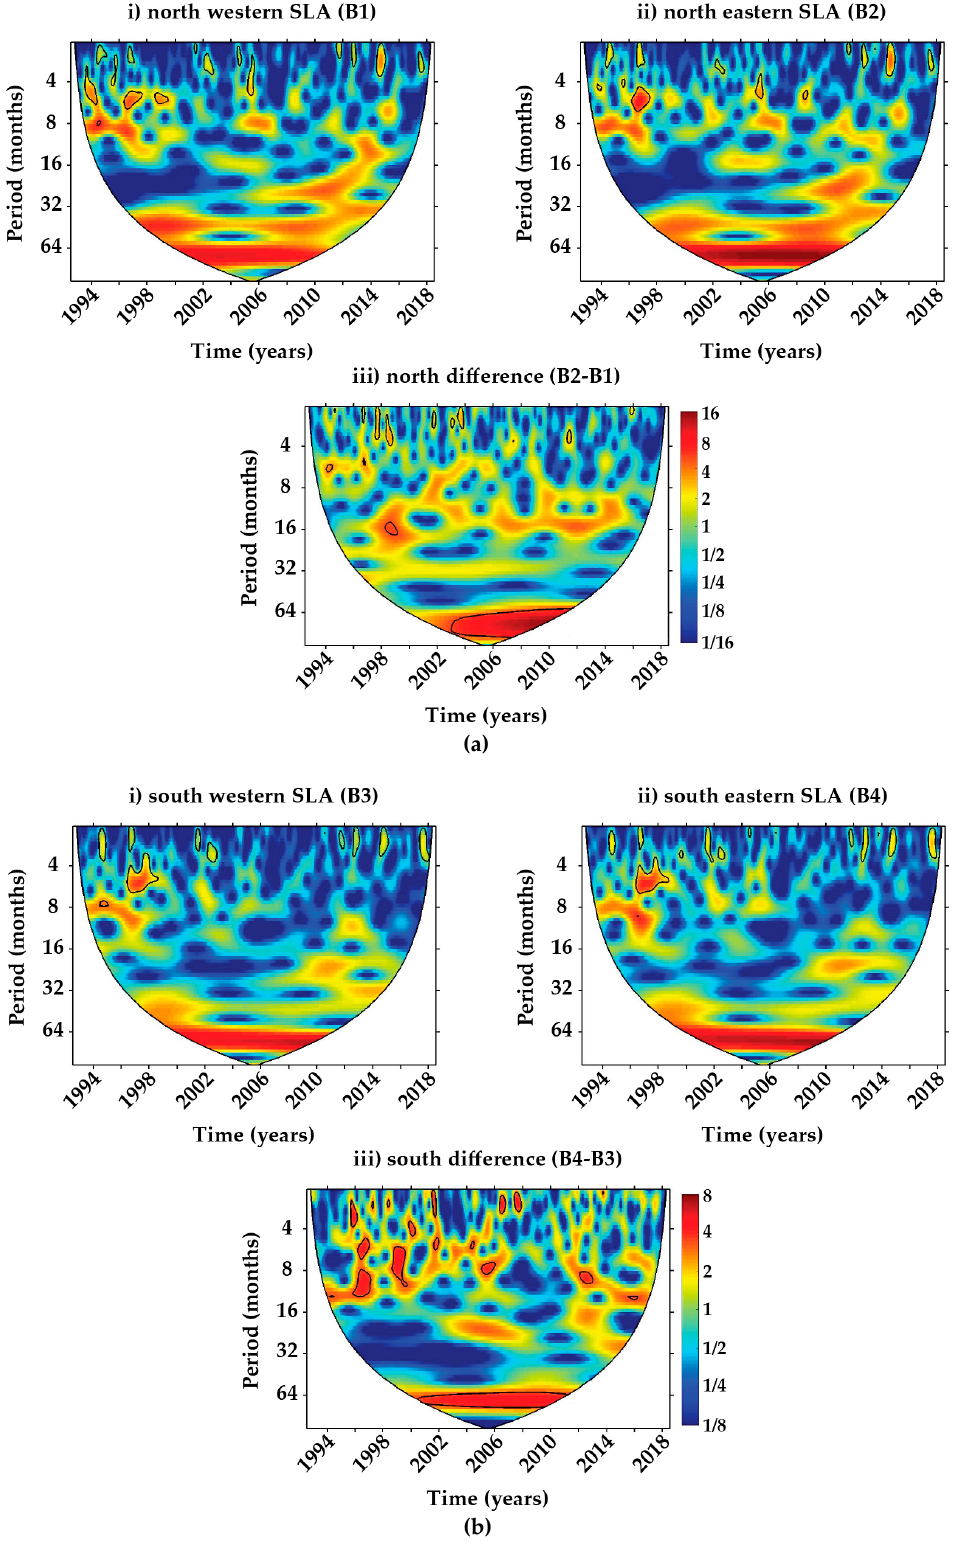
Figure 7. The wavelet plots after removing the annual signals for the western basin, eastern basin, and their difference ( a ) for the northern Red Sea and ( b ) for the southern Red Sea. In brief, a significant seasonally reversing EW difference pattern exists in the Red Sea. The average annual cycle of EW difference for the northern, southern, and whole basin of the Red Sea is shown in Figure 8. On average, the eastern side is higher than the western side from November to March and vice versa from June to September (Figure 8), indicating that the eastern side has a higher sea level for a period twice as long (8 months) as the western side (4 months).